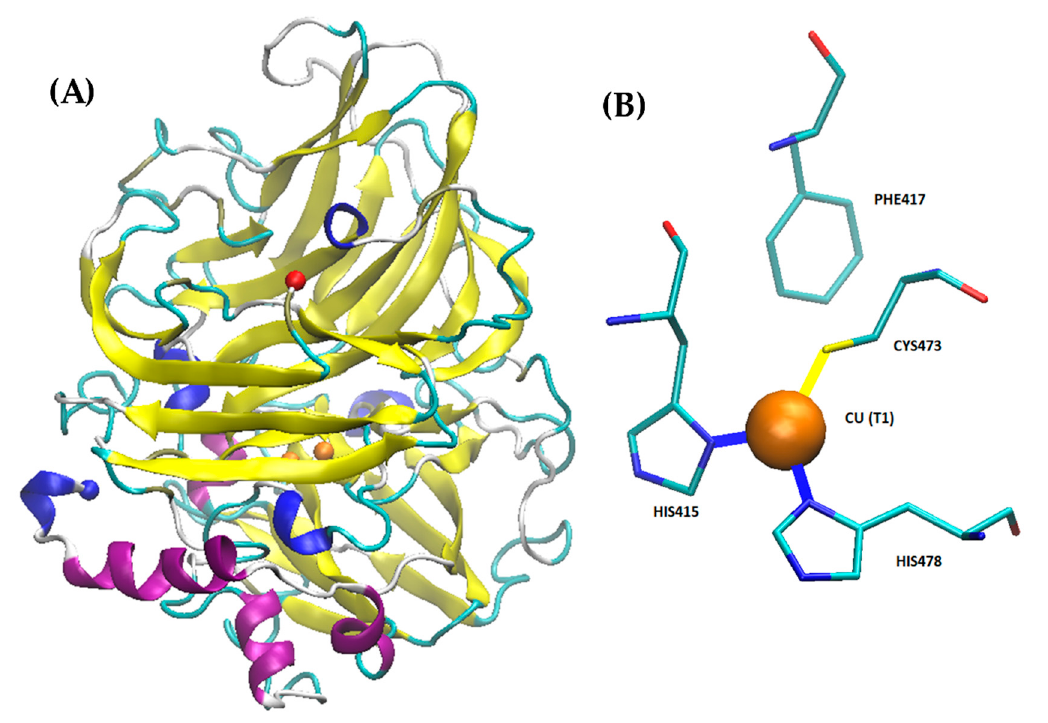
Figure 1. Structure of Laccase from Trametes versicolor . The crystal structure was solved by Choinowski and coworkers; downloaded from rcsb.org (1GYC) ([126,145]). The structure was visualized using Visual Molecular Dynamics (VMD) software. ( A ) 3D structure of laccase. The N- and C-termini are shown as red and blue spheres, respectively, while the copper ions are shown in orange (partially occluded in the structure). ( B ) structural geometry of the mono-copper site with chelating residues highlighted .